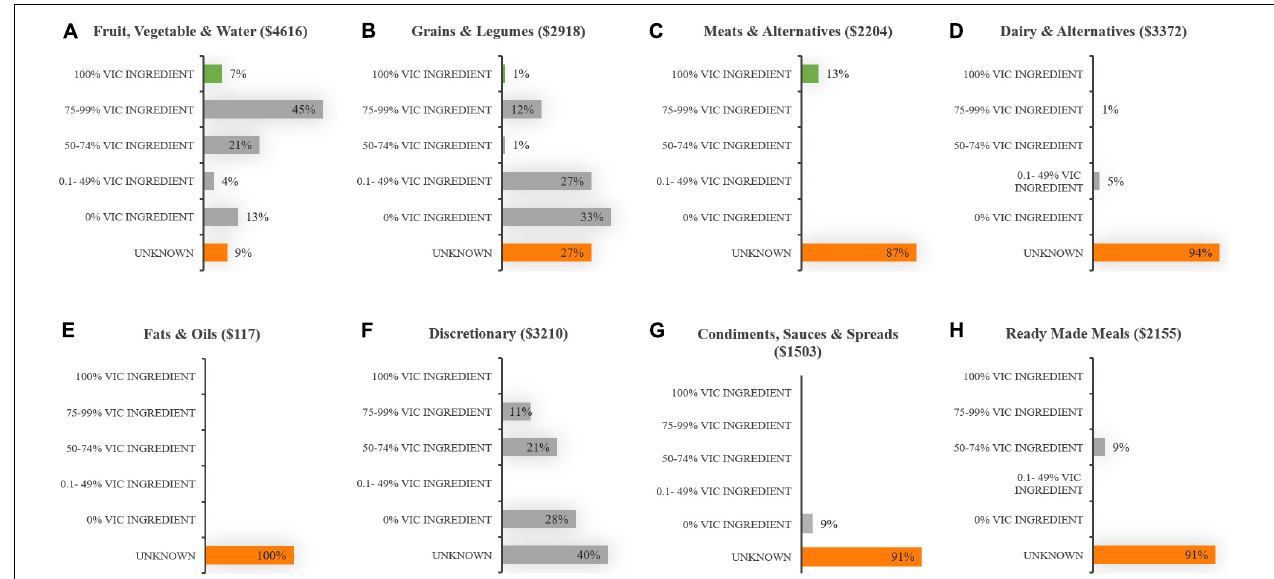
FIGURE 5 | Distribution of the “Australian” food budget across eight food group categories (A–H) , according to its proportion of Victorian (Vic)